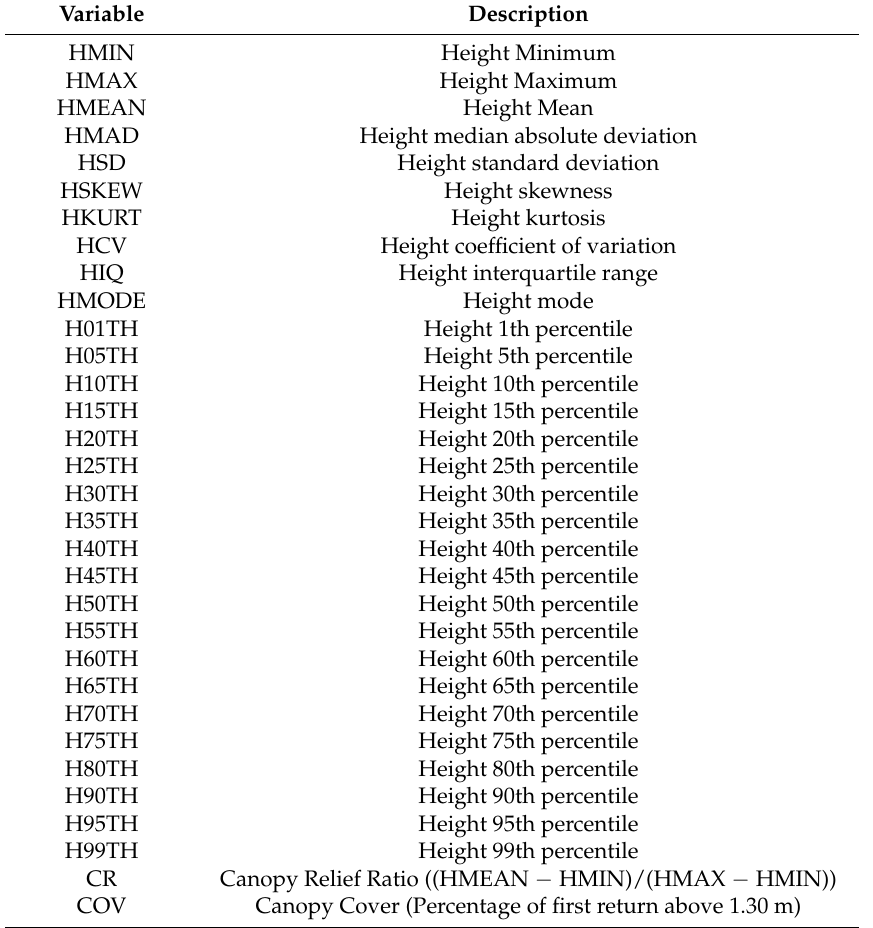
Table 4. Lidar-derived canopy height metrics considered as candidate variables for predictive V models